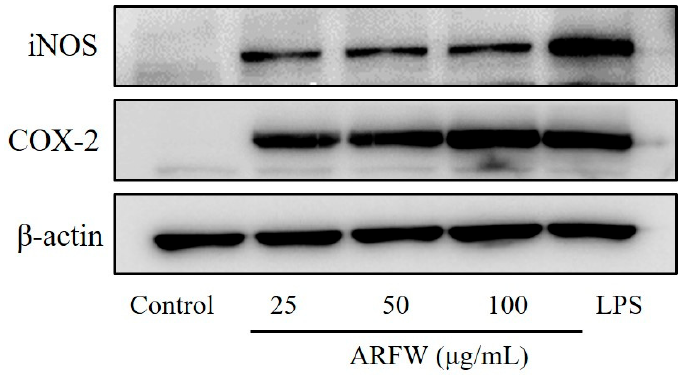
Figure 3. ARFW induced iNOS and COX-2 protein expression. Cells were treated with ARFW or LPS (100 ng/mL) for 18 h and protein expression levels were determined by western blot analysis with specific antibodies.